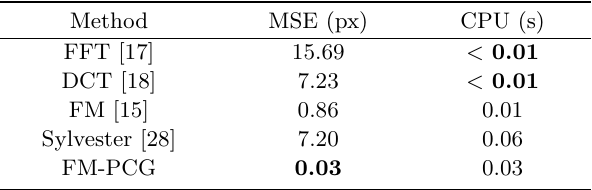
Table 14 Results on the “Peaks” dataset for the non-rectangular domain in Fig. 12(a)